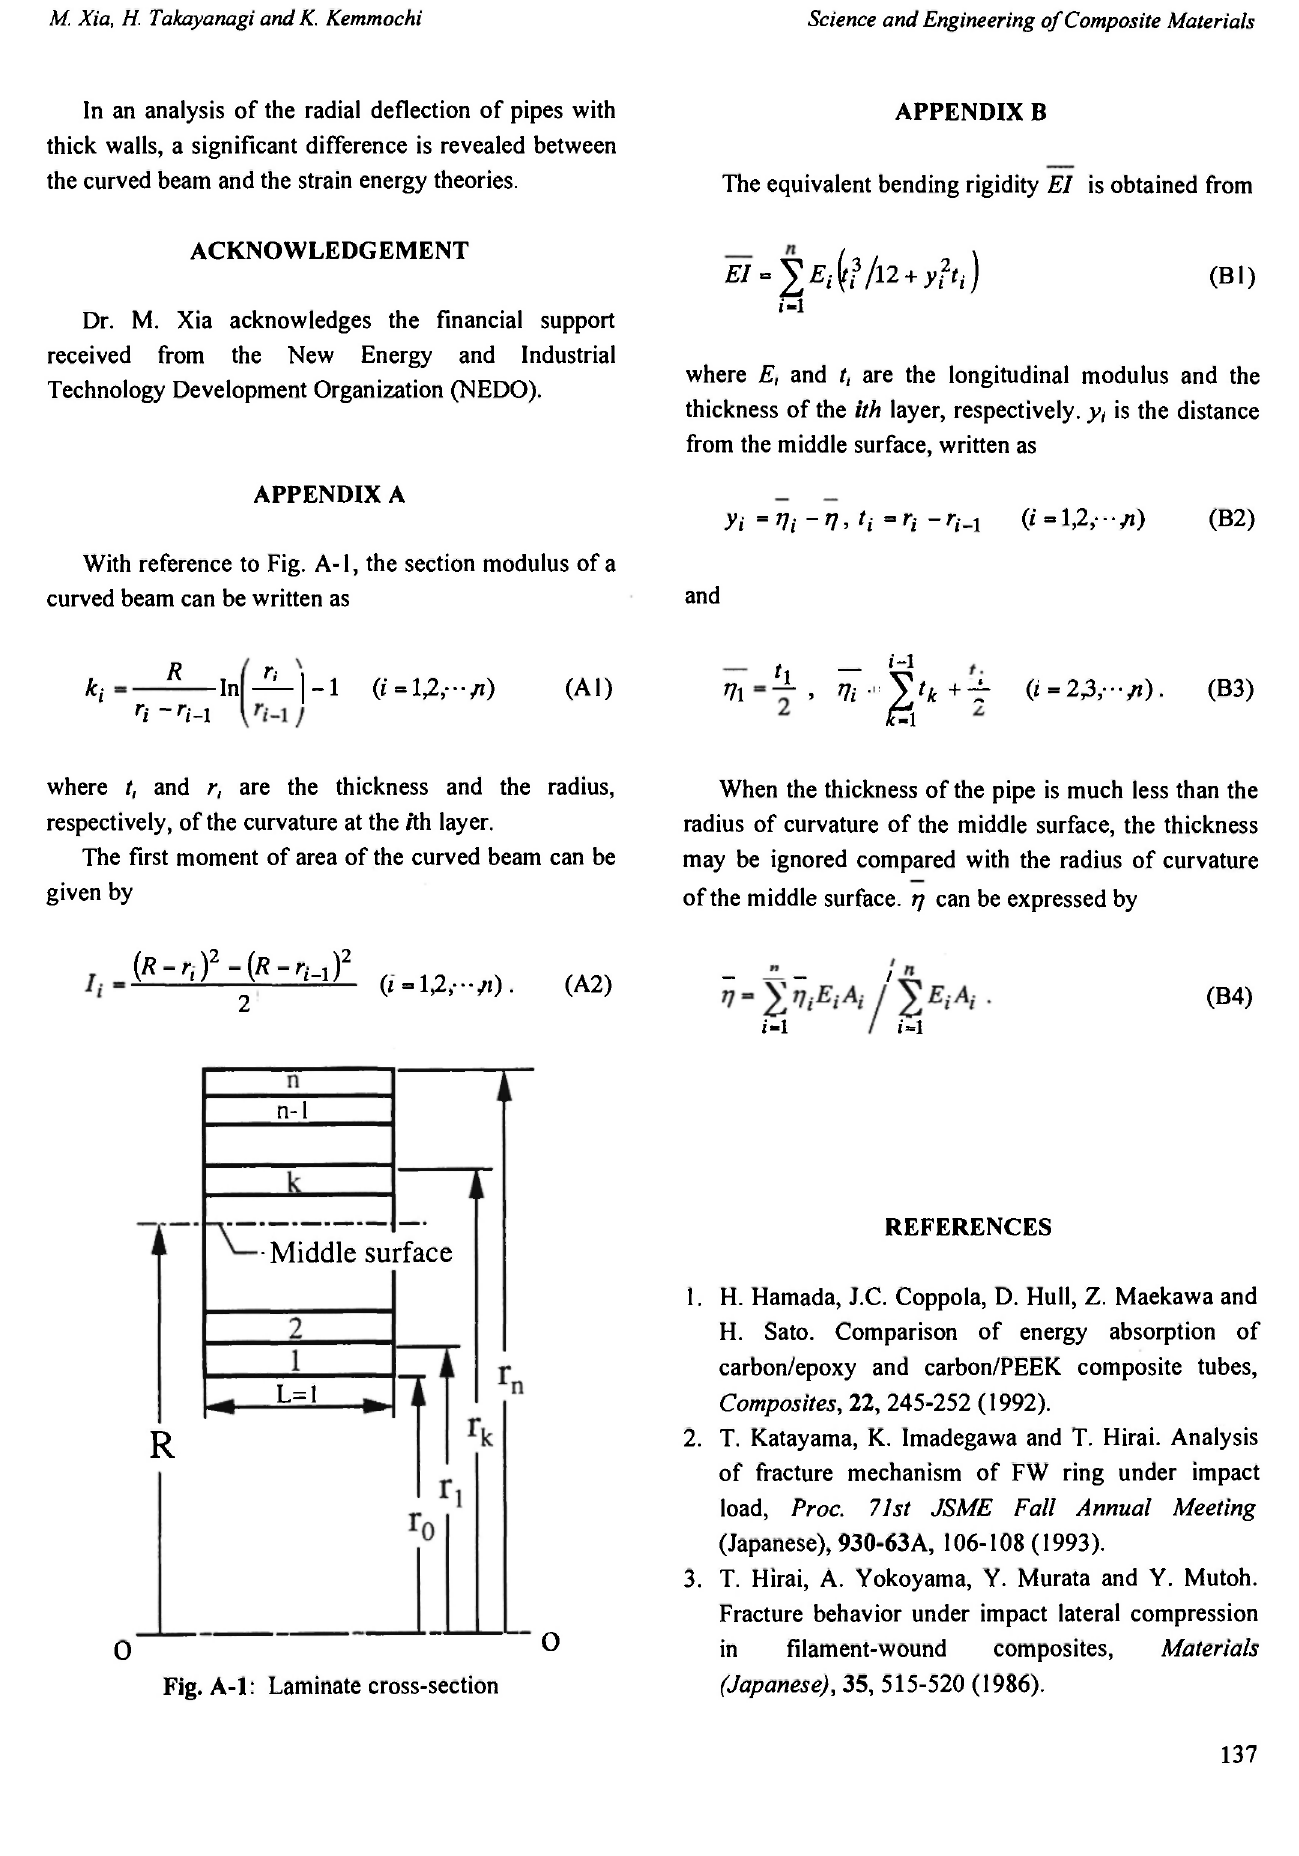
Fig. A-l: Laminate